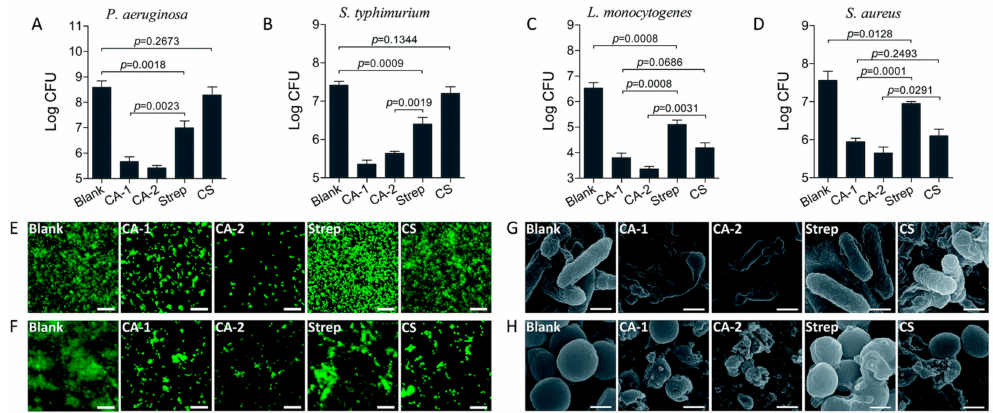
Figure 6. E ff ect of CA NPs on prefabricated biofilms formed by gram-negative and